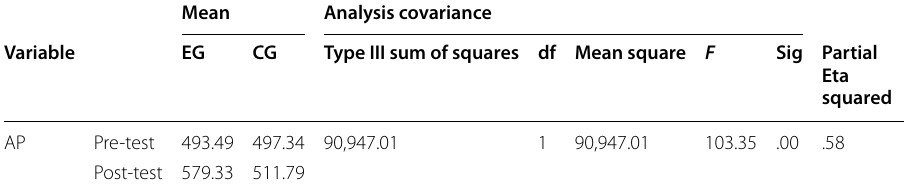
Table 5 Results of ANCOVA for academic emotions